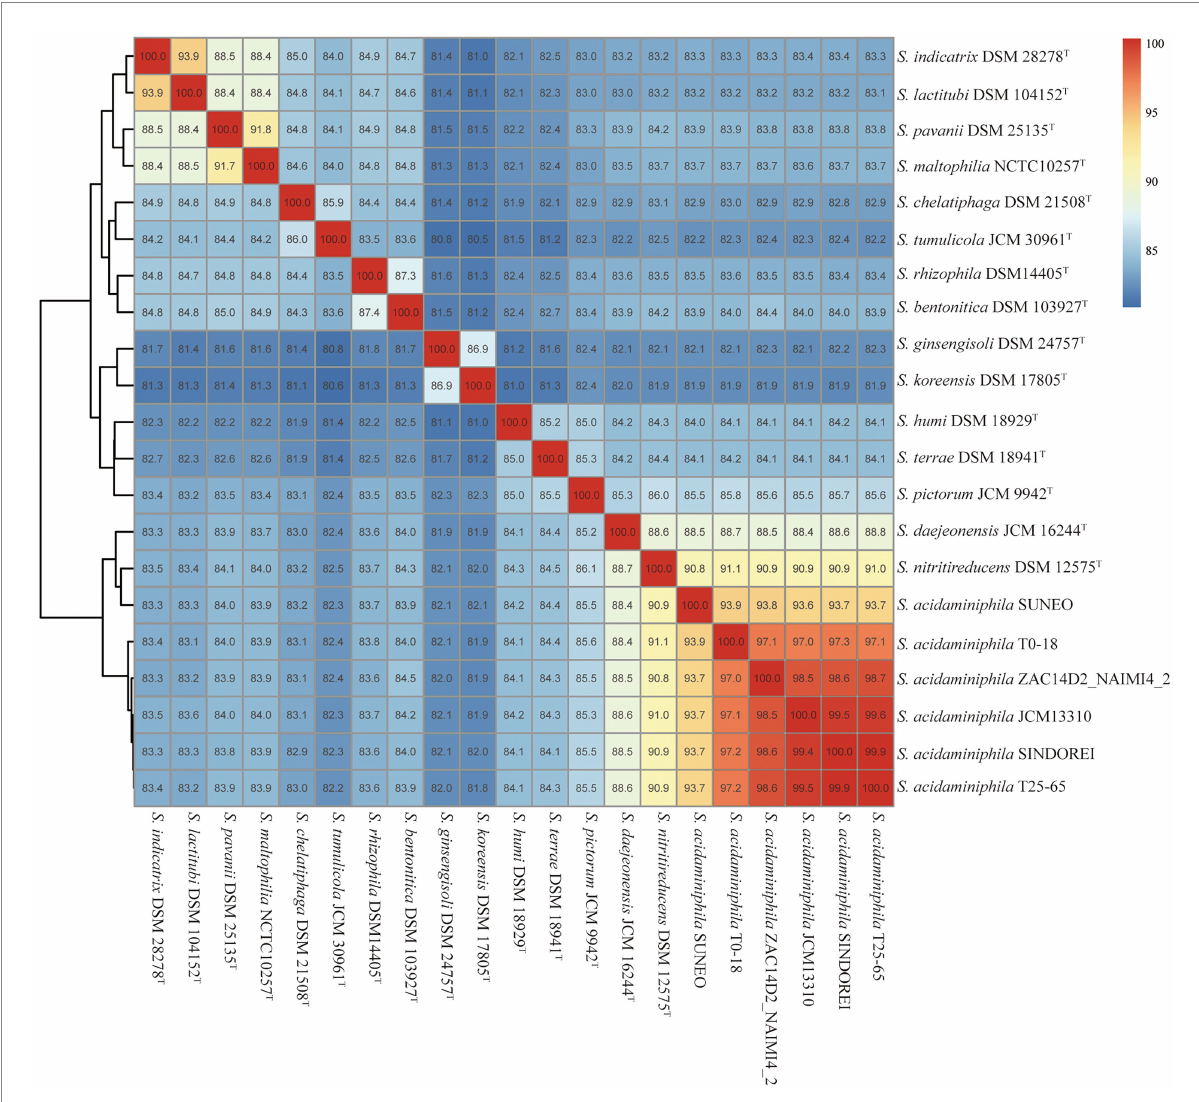
FIGURE 3 ANI values of Stenotrophomonas acidaminiphila SINDOREI with the type strains of genus Stenotrophomonas